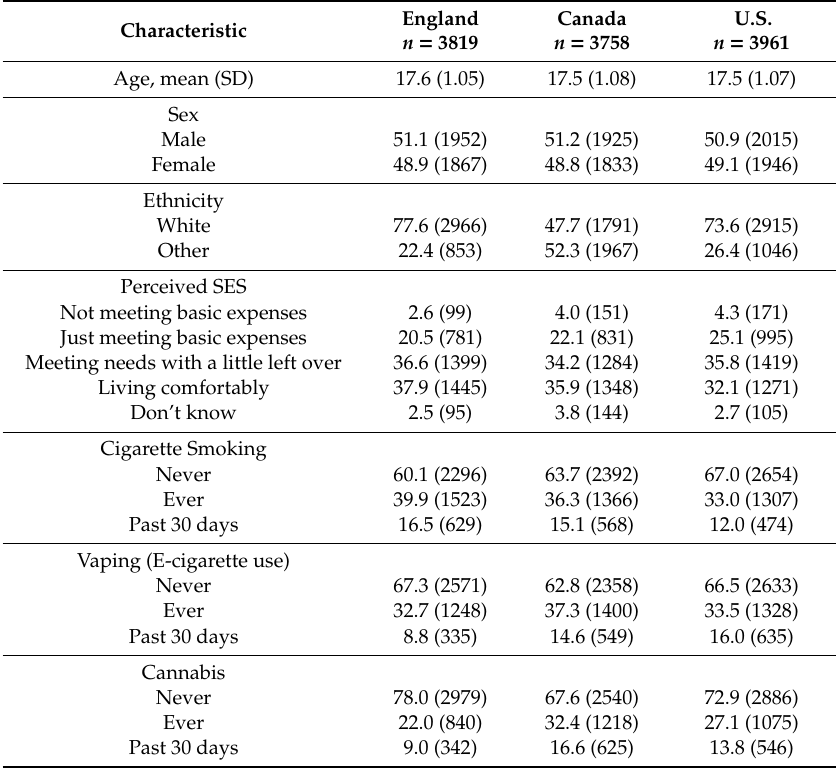
Table 1. Sample characteristics by country